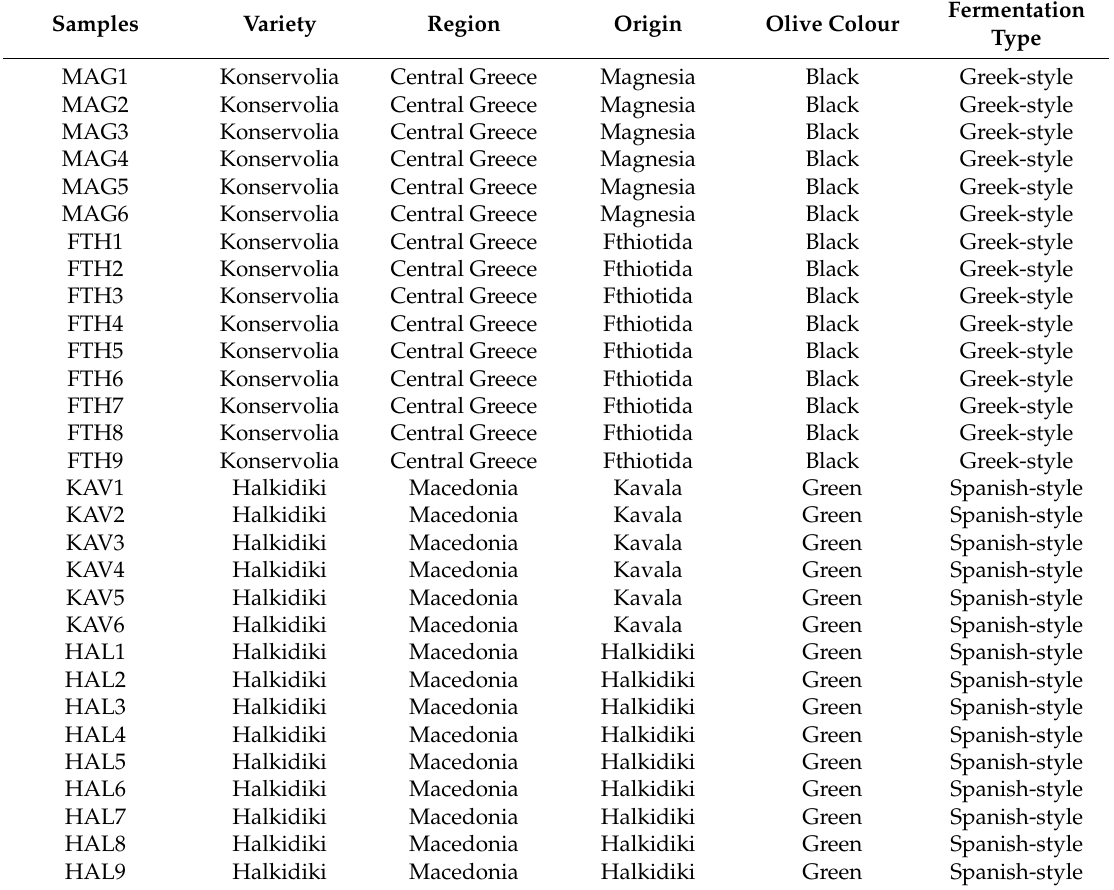
Table 1. Geographical origin of the fermented cv. Konservolia natural black and cv. Halkidiki Spanish-style green olive